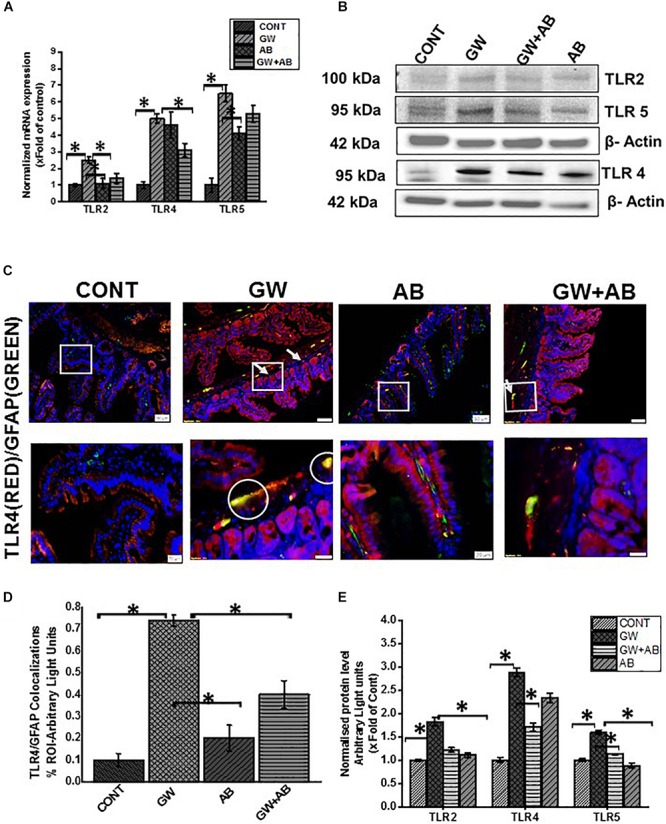
Expression of Toll-like receptors in small intestine and EGC. (A,B) General mRNA and protein expression levels of toll-like receptors TLR2, TLR4, and TLR5 in small intestine of mice treated with vehicle control (CONT, n = 9), gulf war chemical treated mice (GW, n = 9) and mice treated with antibiotics only (AB, n = 4) and mice co-exposed with GW chemicals and antibiotics (GW + AB, n = 9). mRNA expression was determined by RTqPCR, while protein expression was determined by western blot analysis. (E) Quantitative morphometric analysis of western blot bands normalized against β-actin The Y axis shows protein/β-actin ratio Results are expressed as mean ± SEM for n = 9 (∗P < 0.05). (C) Tissue level expression of TLR4 in EGC in small intestine. Expression of TLR4 in EGC was observed by in dual labeling of TLR4 and EGC cells marker GFAP via immunofluorescent microscopy visualized at (top panel magnification 200X; scale 100 μm and bottom panel magnification 600X; scale 20 μm) in small intestine tissues obtained from mice treated with vehicle control (CONT, n = 9); mice treated with GW chemicals (GW, n = 9) mice, mice treated with antibiotics only (n = 4) and co-exposed with GW chemicals and antibiotics (GW + AB, n = 3). (D) Quantitative morphometric analysis of immunoreactivity of GFAP/TLR4 (yellow) is represented as colocalizations events per field from randomly chosen microscopic fields (∗P < 0.05).